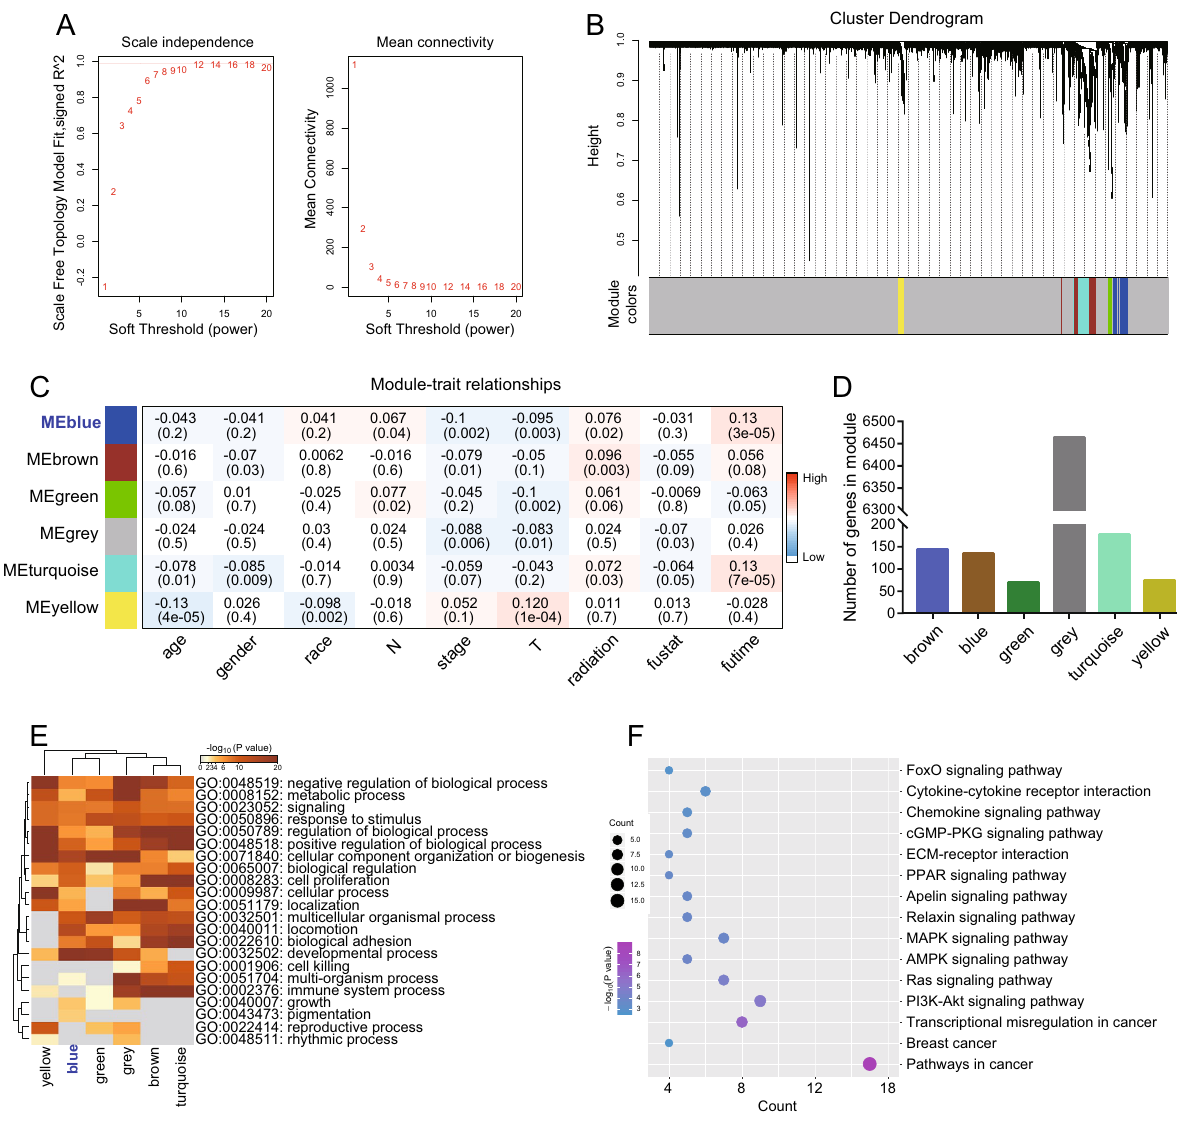
Figure 4. WGCNA analysis used to identify modules significantly associated with breast cancer prognosis. ( A ) Analysis of network topology for various soft-thresholding powers. ( B ) Module clustering analysis based on eigengenes. ( C ) Correlation analysis of each module and its traits. ( D ) Frequency statistical analysis of genes in each module. ( F ) Functional enrichment analysis of breast cancer prognosis-related modules. E: KEGG Enrichment Analysis of unregulated genes in MEblue